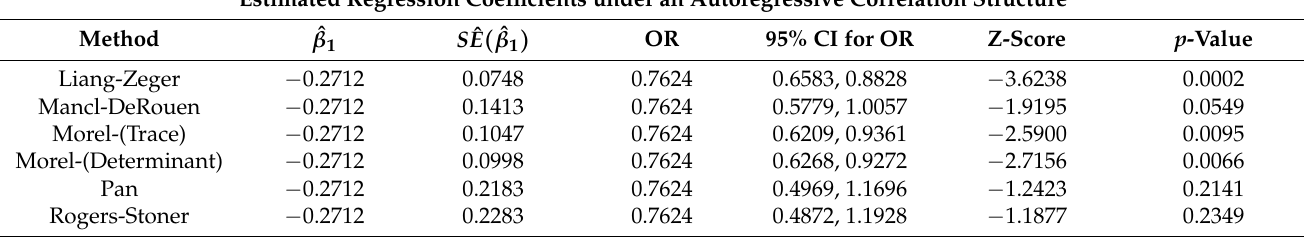
Table 5. Estimated regression coefficients, odds ratios (OR), standard errors, 95% confidence intervals (CI) from analysis of repositioning events in recorded ICU SpO 2 measurements within the first 24 h for 20